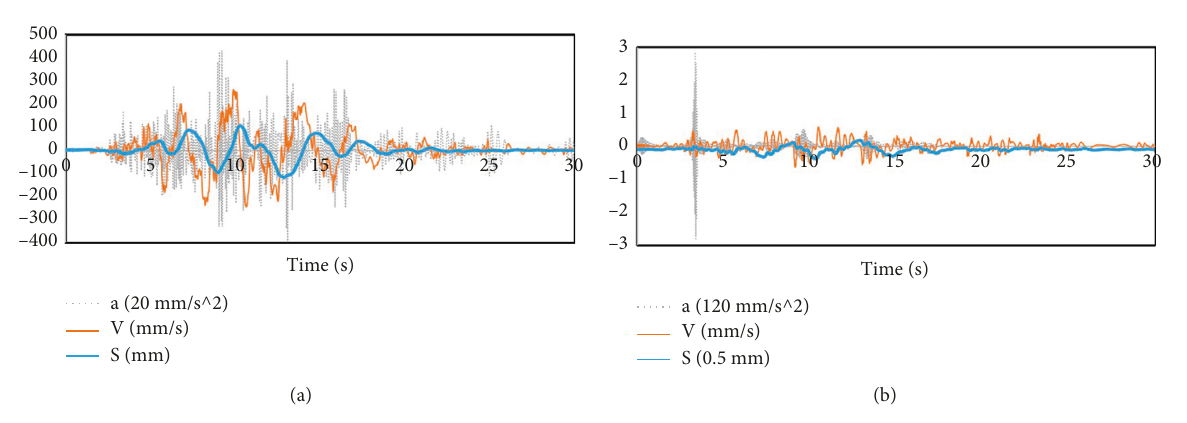
Figure 46: Time course curves of displacement, velocity and acceleration of bearing deformation when REN1 is input from Y direction. (a) Horizontal deformation. (b) Vertical deformation.